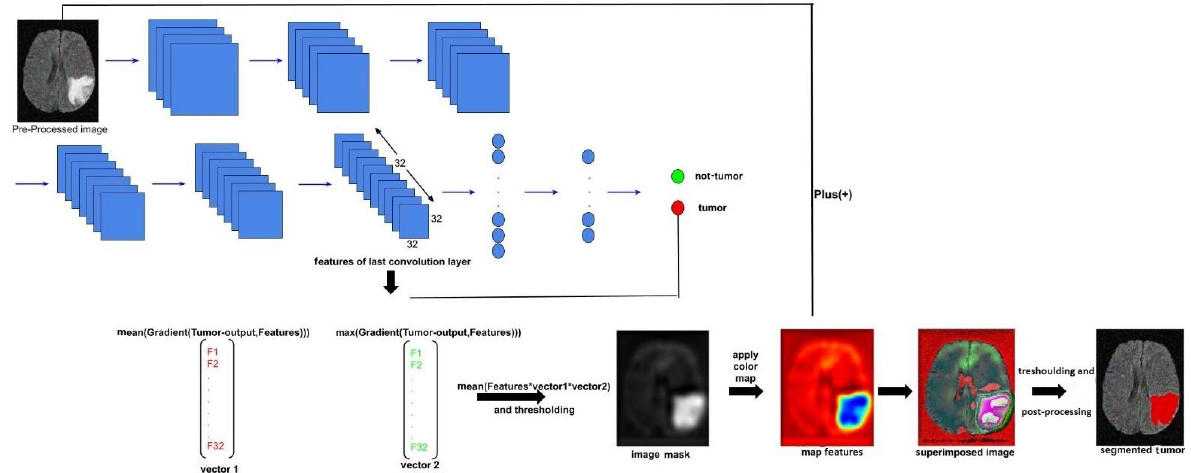
Figure 6. Illustration of our tumor segmentation process of an MRI image from training BraTS 2017 dataset.